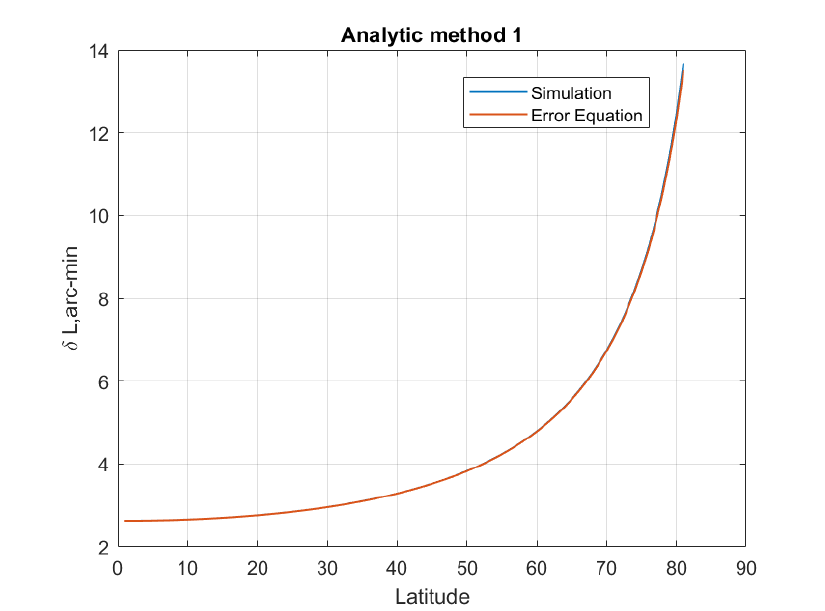
Figure 8. The latitude error of the analytic method 1 with latitude increasing.